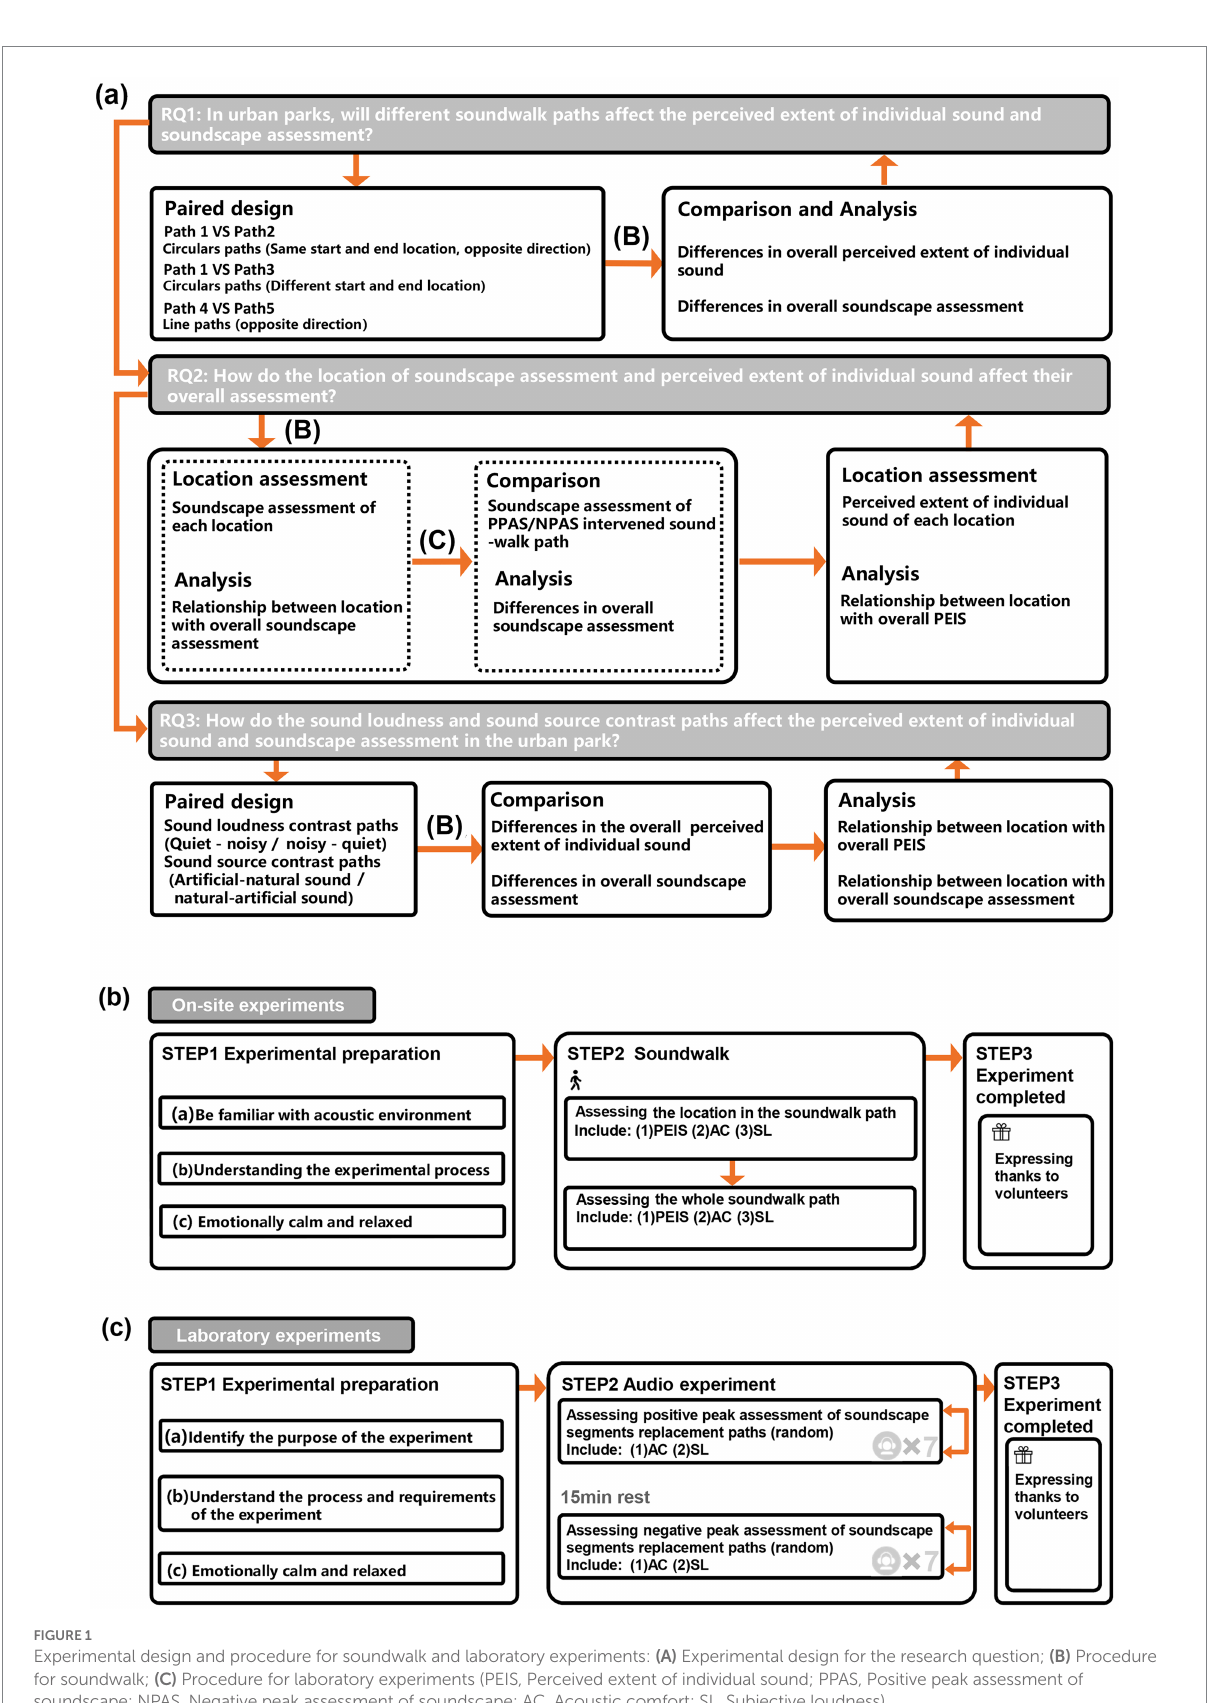
FIGURE 1 Experimental design and procedure for soundwalk and laboratory experiments: (A) Experimental design for the research question; (B) Procedure for soundwalk; (C) Procedure for laboratory experiments (PEIS, Perceived extent of individual sound; PPAS, Positive peak assessment of soundscape; NPAS, Negative peak assessment of soundscape; AC, Acoustic comfort; SL, Subjective